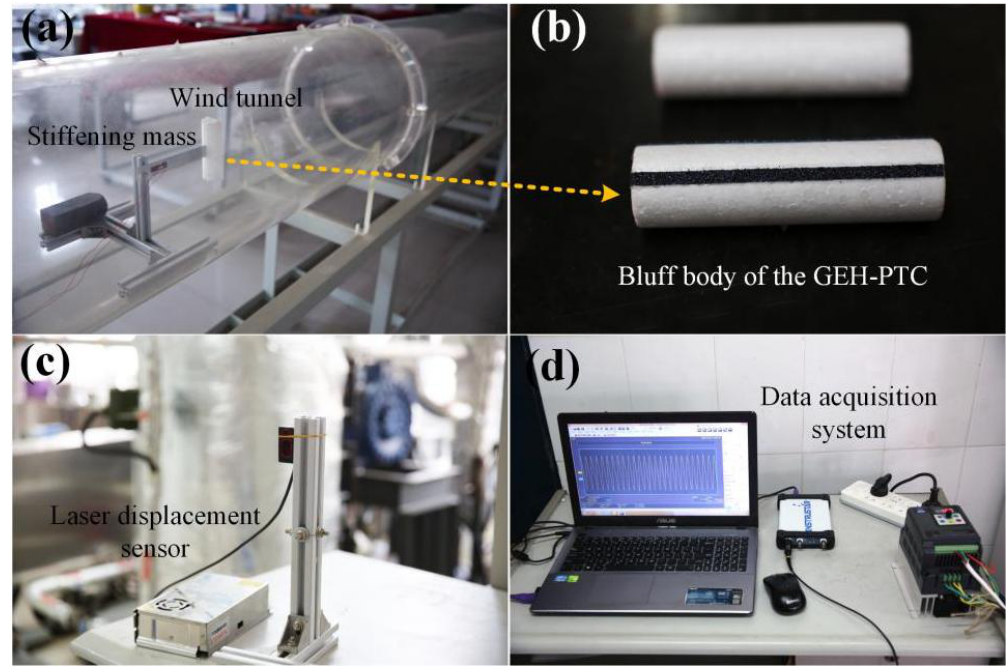
Figure 2. Experimental setup: ( a ) the wind tunnel with the bluff body with attachments (PTC), which is made of ( b ) sanding belts with a very coarse surface, ( c ) the laser sensor, and ( d ) the data acquisition system.